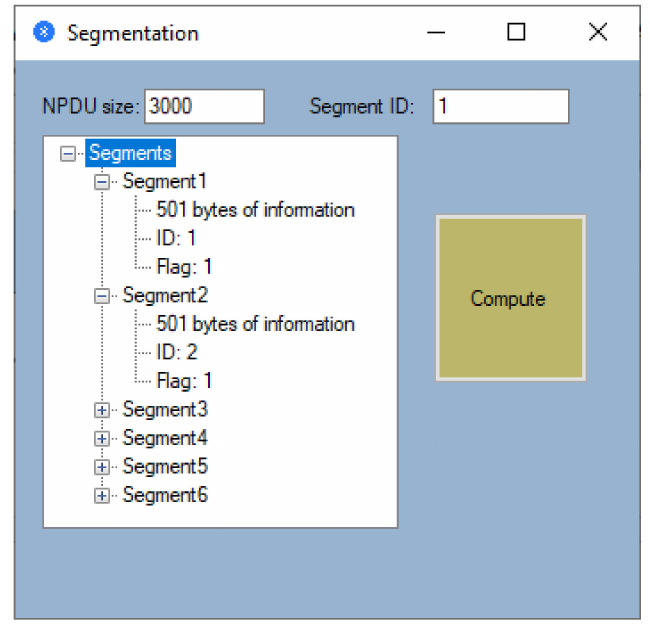
Figure 9. Example of a segmentation